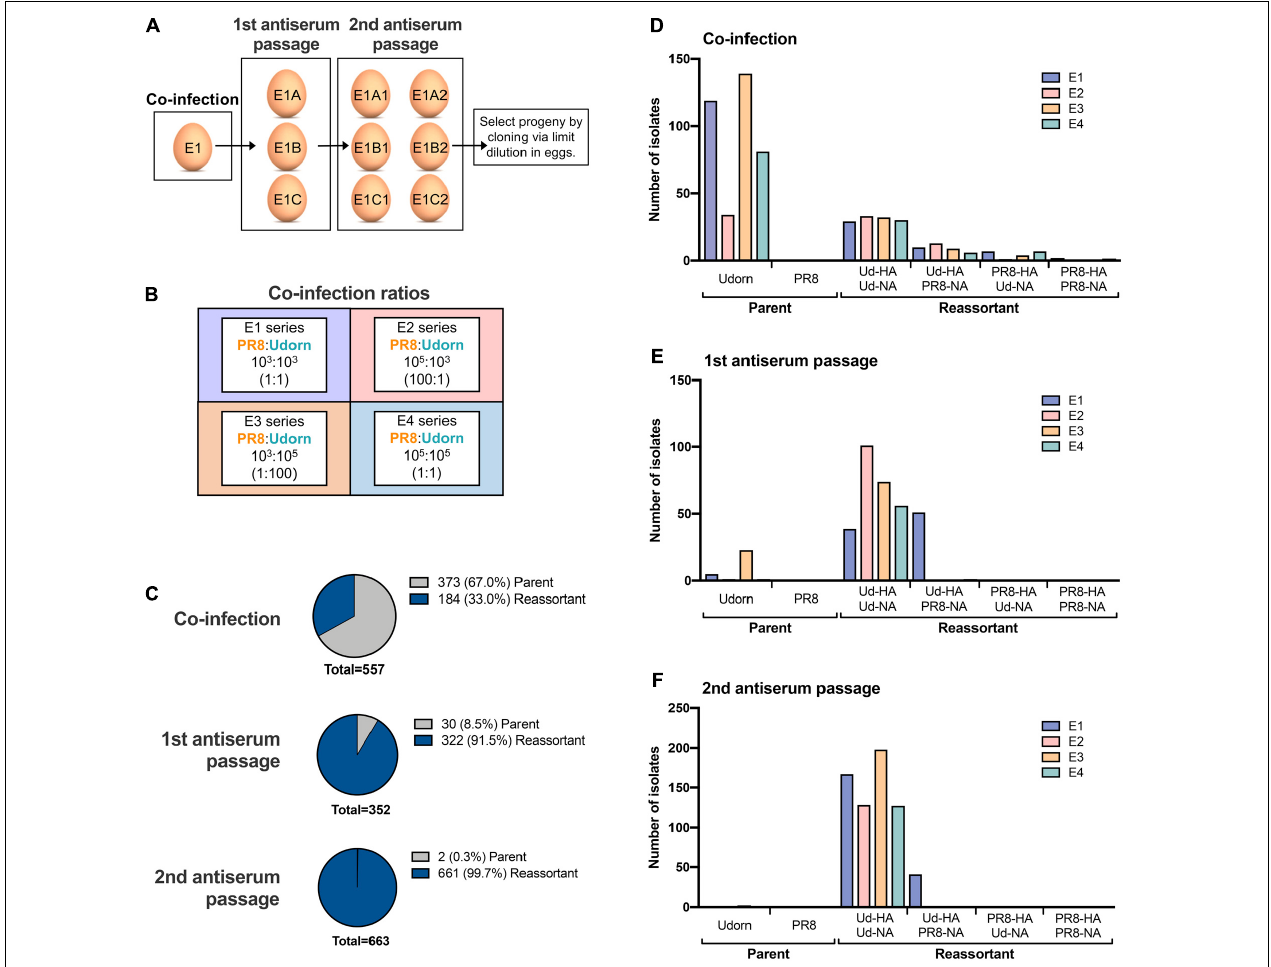
FIGURE 1 | The frequency of parent versus reassortant genotypes isolated throughout the classical reassortment process. (A) Schematic overview of the classical reassortment process used for the generation of seasonal influenza vaccine seeds. Ten-day-old embryonated hen’s eggs were co-infected with PR8 and Udorn viruses. The allantoic fluid from these eggs was then harvested and passaged into three eggs (e.g., E1A, B, and C) in the presence of antiserum against the PR8 surface glycoproteins. The allantoic fluid from each of these eggs was then further passaged into two eggs (e.g., E1A1 and E1A2). Viruses from these were cloned by limit dilution. (B) The experiment was carried out four times at different co-infection ratios (series E1-E4). The co-infection ratios and amounts of infectious PR8 and Udorn virus (PFU) used to inoculate the first eggs of each series are indicated. (C) The ratio of reassortant genotypes to the Udorn parent at each stage of the classical reassortment process. Viruses in the allantoic fluid were isolated by plaque formation in MDCK cells. For the co-infected eggs, plaquing was performed in the presence of anti-PR8 antiserum. Individual plaques were picked into 0.05% Triton X-100 and gene specific RT-PCR performed to determine the origin of each gene. (D–F) The number of PR8 and Udorn parent genotypes recovered as well as the number of viruses containing different combinations of HA and NA genes present on reassortant viruses in (D) the initial coinfection, (E) the first antiserum passage, and (F) the second antiserum